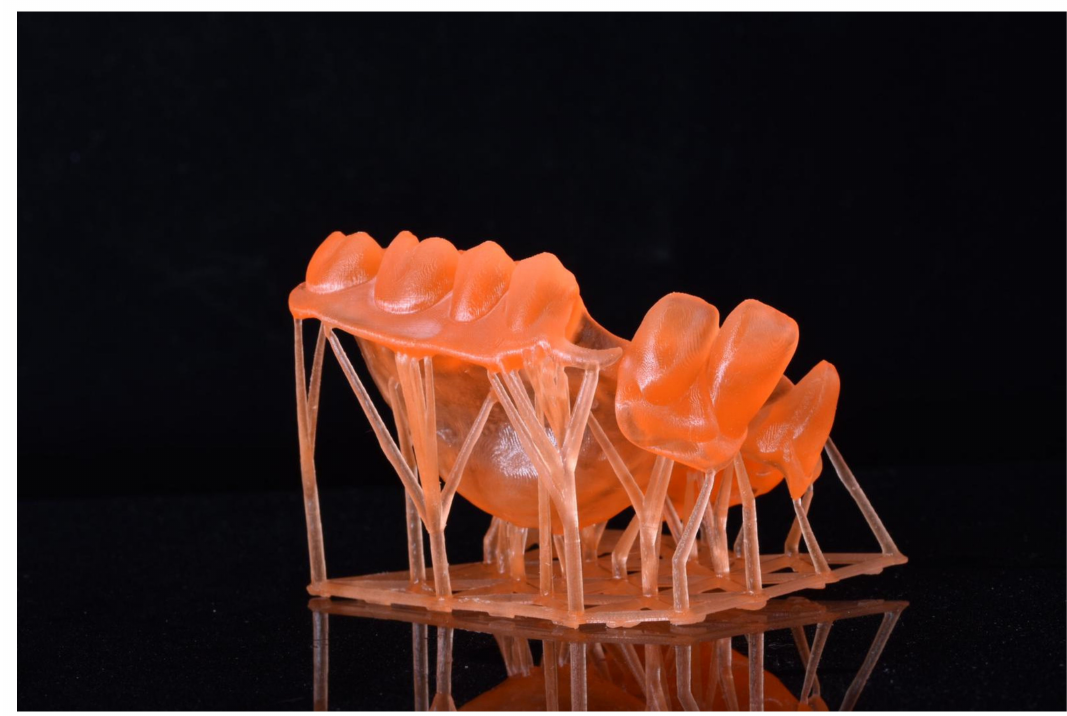
Figure 5. Sample of new devices like 3D printing for having dental threedimensional